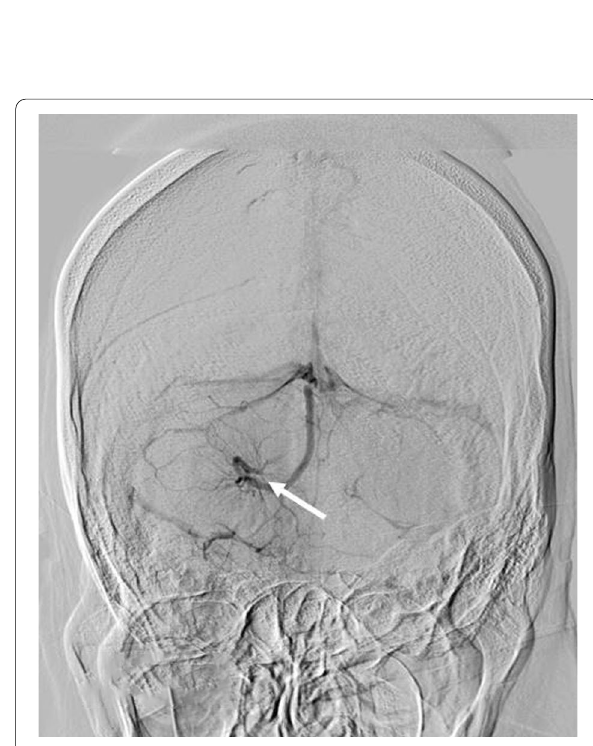
Fig. 7 Developmental venous anomaly (DVA) or venous angioma; DSA image in AP view showing ‘medusa head’ appearance (white arrow) of medullary veins with early dilated draining vein into